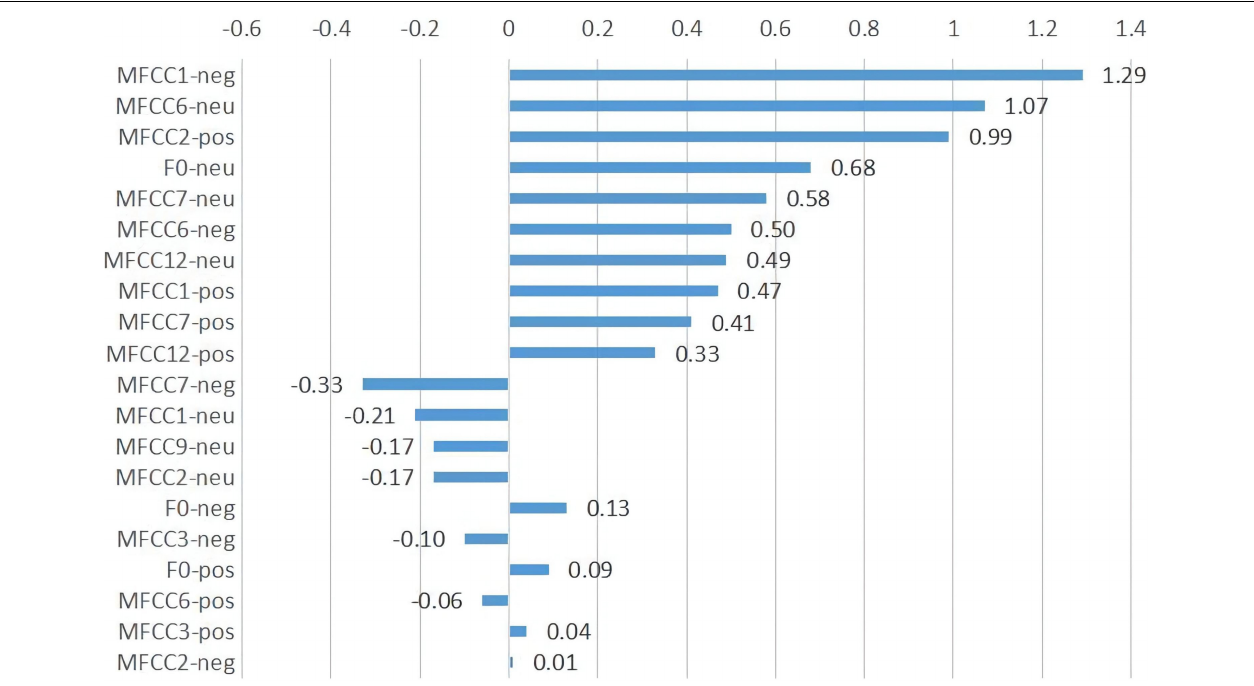
FIGURE 2 | The 20 acoustic features with the largest contribution in LR model. pos, positive emotion task; neg, negative emotion task; neu, neutral emotion